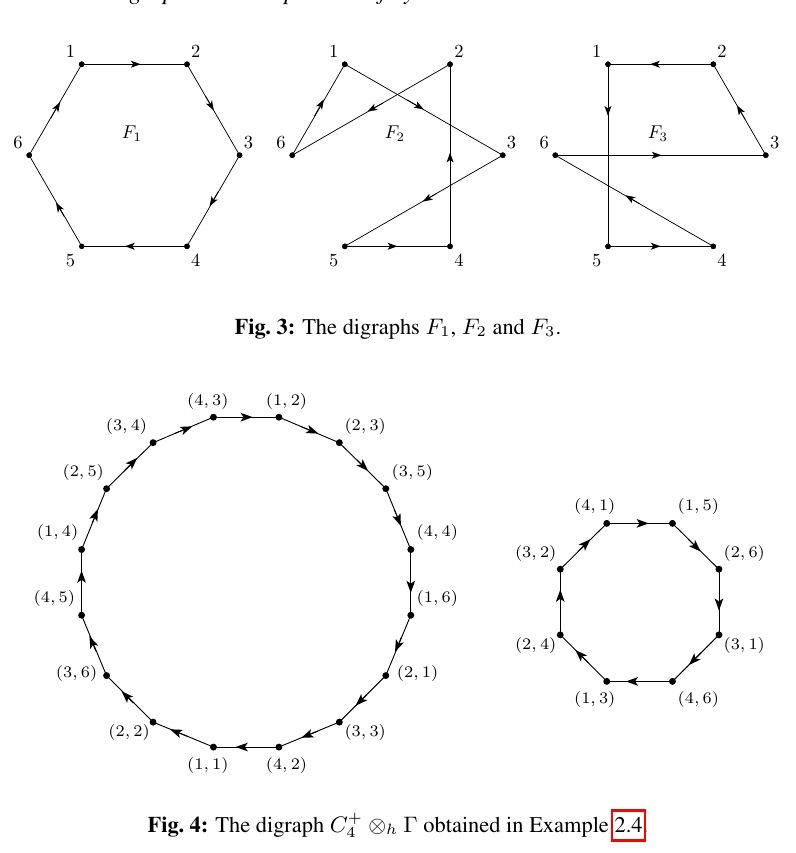
Fig. 4: The digraph C +